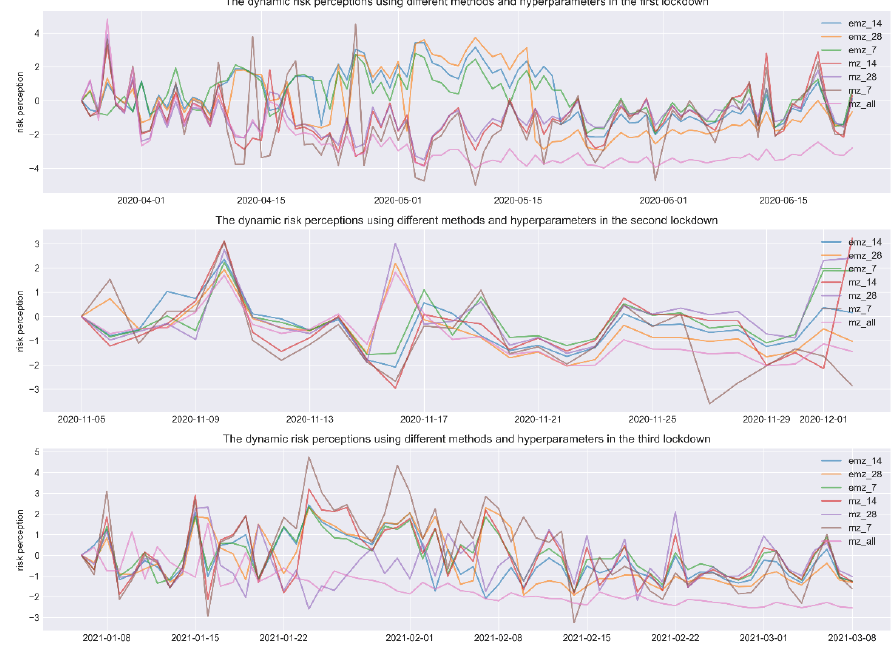
Figure A2. The dynamic risk perceptions generated by different methods in three lockdown periods.